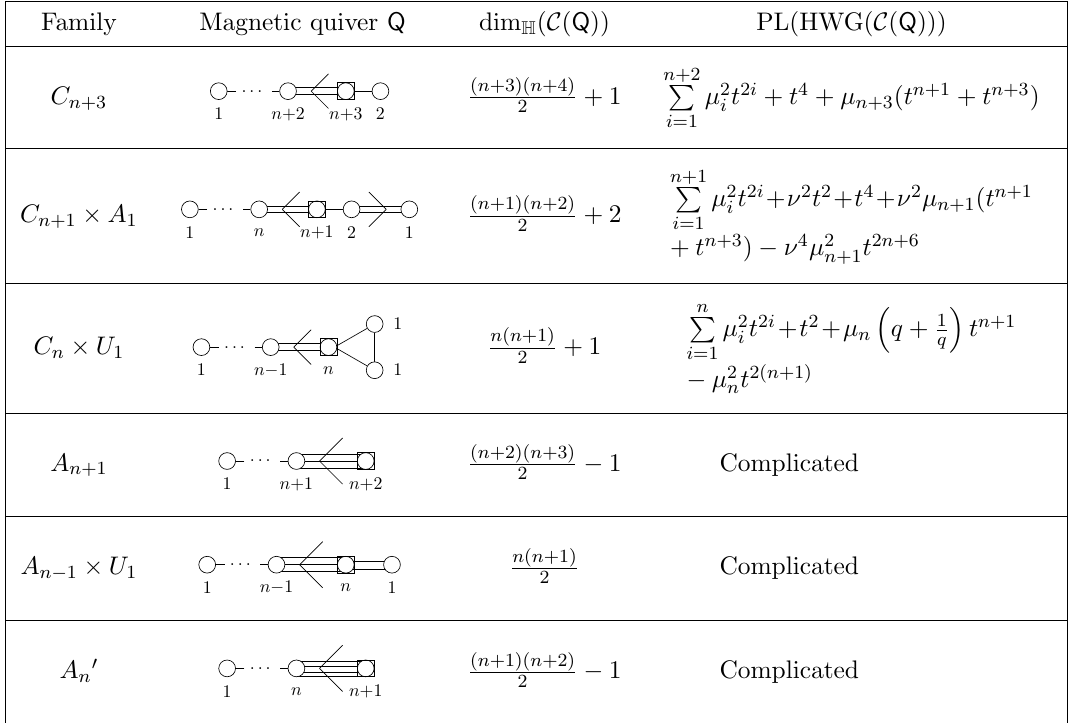
Table 11 . General quiver families obtained by folding the legs in the magnetic quivers Q 0 in table 10. In the case of n = 2 these families correspond to the magnetic quivers of 4 d rank 1 theories with enhanced Coulomb branch. For n > 1 the families are labelled by their global symmetry. For n = 1 the magnetic quivers describe rank 1 theories without enhanced Coulomb branch, and for n = 0 each of the moduli spaces is some H l for a suitable l . The dimensions and the HWGs of the Coulomb branches of the magnetic quivers